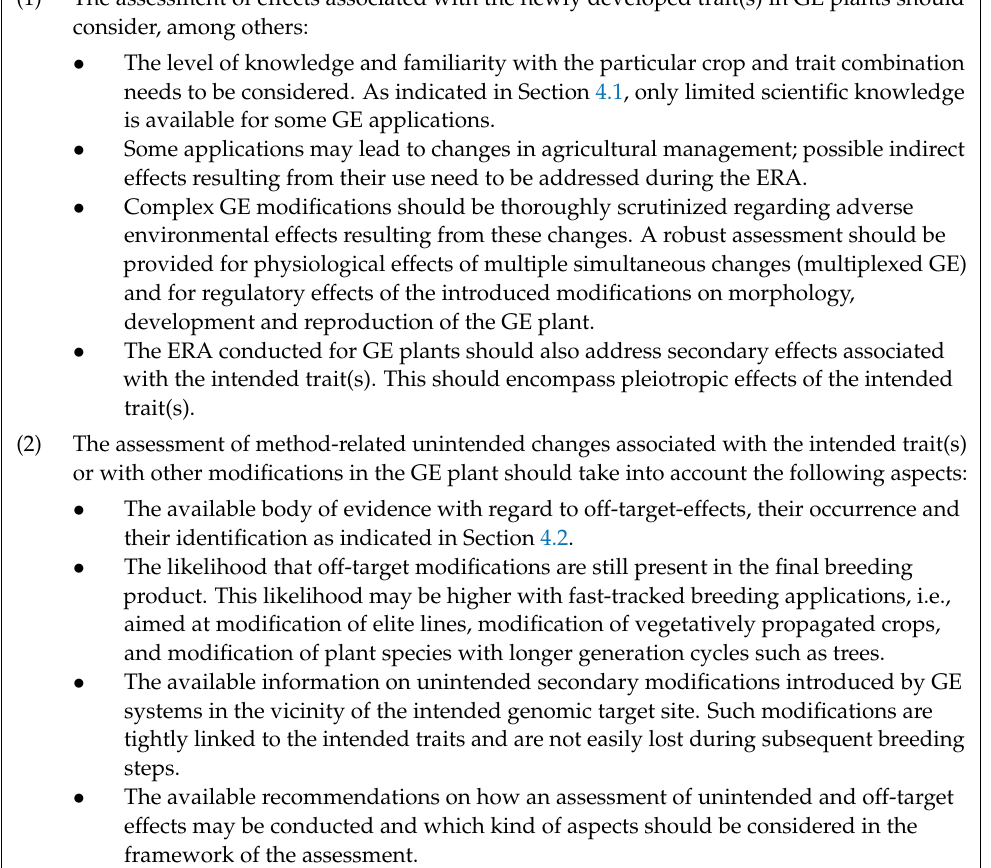
Box 1: Crucial aspects for a two-pronged assessment strategy to address trait-related effects and method-related modifications,